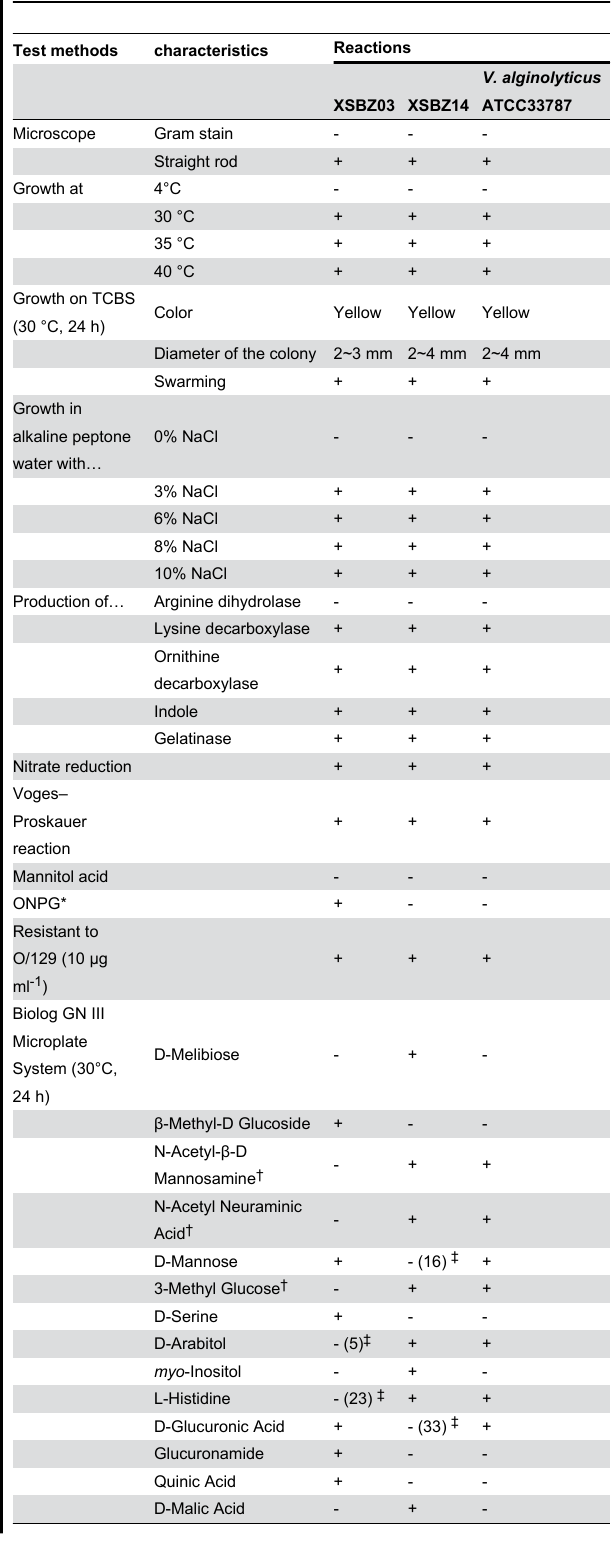
Table 1. Results of the transmission experiment on Porites andrewsi .